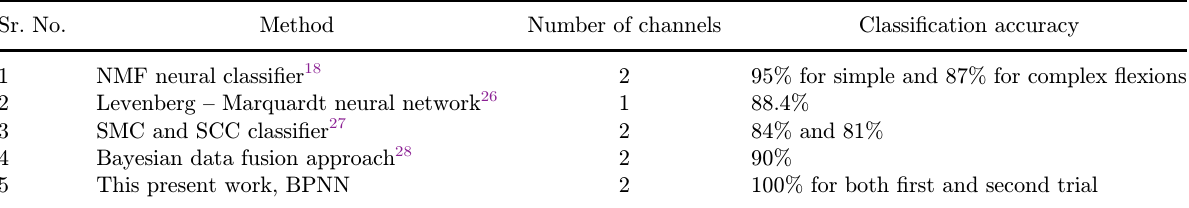
Table 7. Summary of neural network based signal classi¯cation from EMG. Sr.